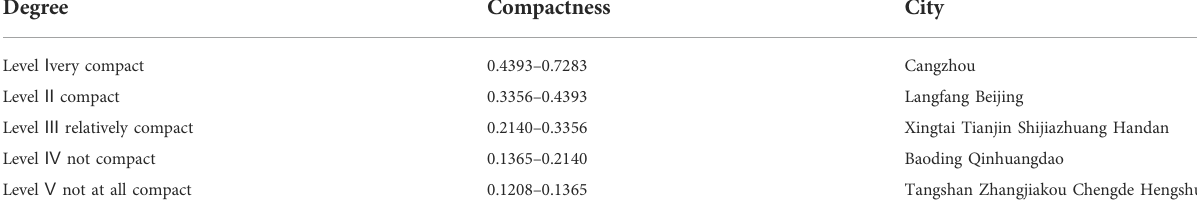
TABLE 3 Classi fi cation of the Jingjinji urban agglomeration